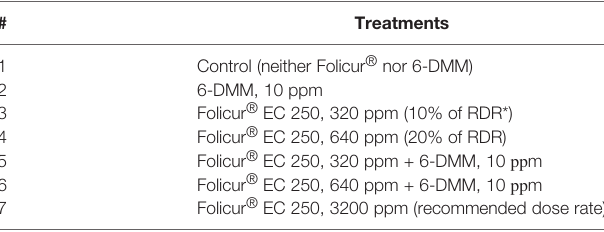
TABLE 1 | List of preventive or curative seedling treatments that were used in greenhouse experiments. #